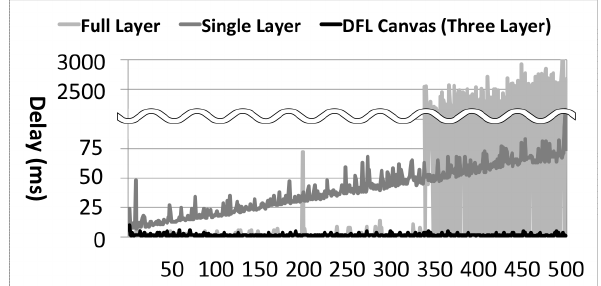
Fig. 7. Synchronization delay of SL, FL and DFL Canvas